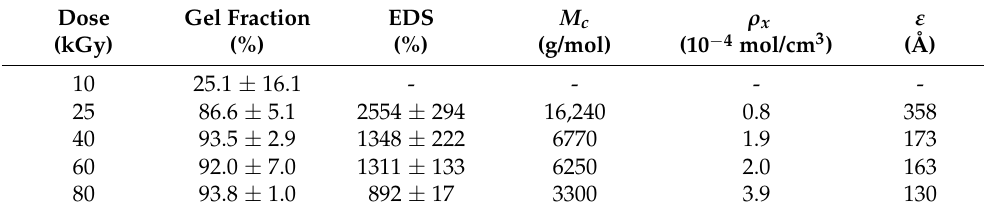
Table 1. Gel fraction, equilibrium degree of swelling (EDS), and network parameters ( M c , ρ x , and ε ) of crosslinked PVA hydrogels as a function of irradiation doses. Each value of the EDS and gel fraction data represents the mean ± SD (n =